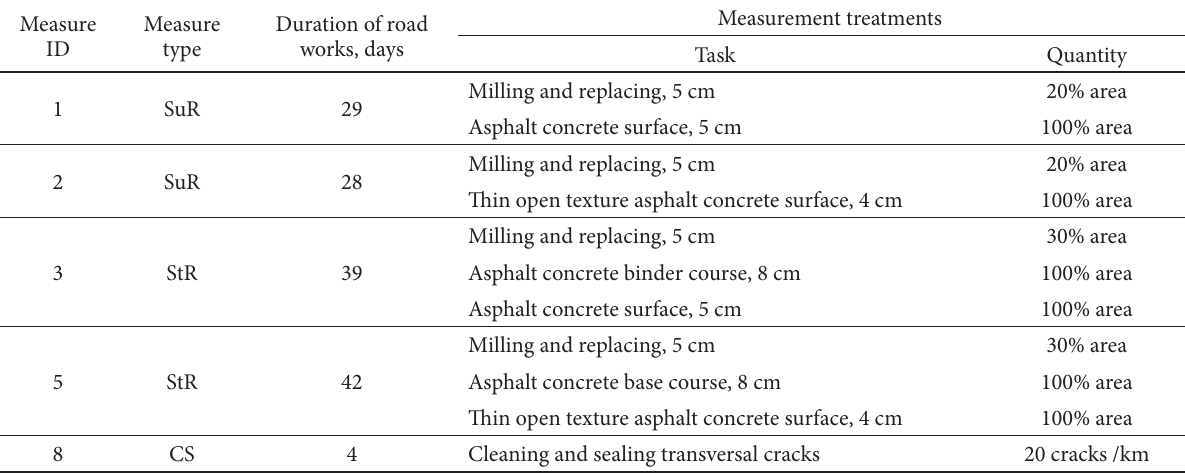
Table 5. Maintenance treatments